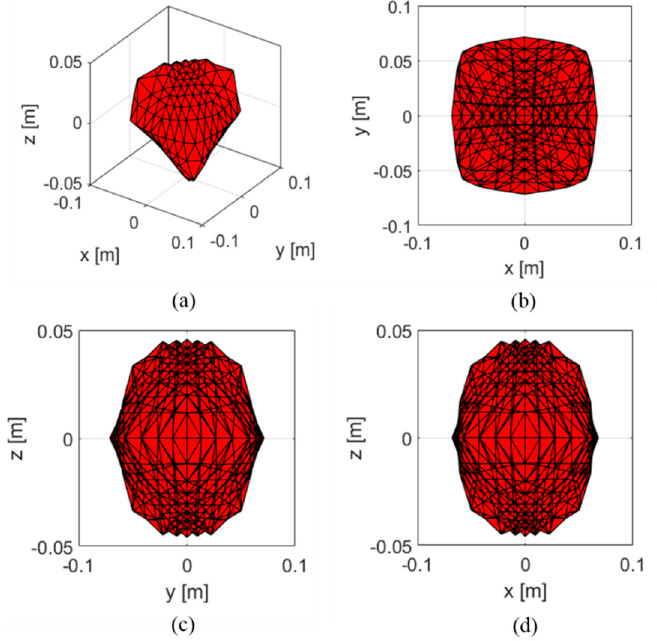
Figure 3. Estimated workspace boundary of the proposed system: ( a ) Workspace in 3D space; ( b ) Workspace in X-Y plane; ( c ) Workspace in Y-Z plane; ( d ) Workspace in X-Z